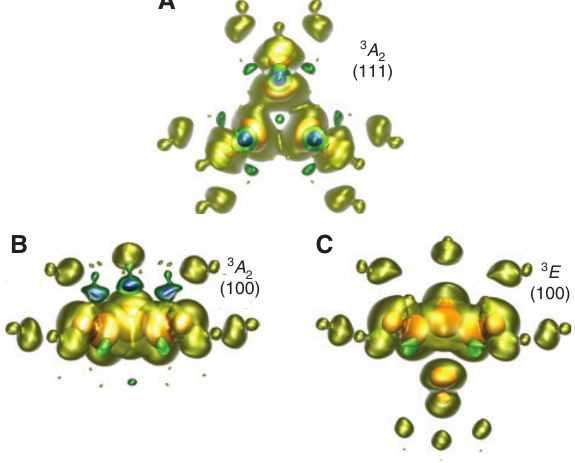
Figure 11: Calculated spin density in a 512-atom supercell in Ref. [3]. The isosurfaces of blue, green, yellow, orange, and red lobes are −0.014, −0.007, + 0.014, + 0.126, and + 0.478, respectively. (A) 3 A 2 state top view of the (111) plane. The threefold rotation symmetry of the C point group can be well identified with symmetrically 3 v equivalent ions around the vacancy. The red lobes show the position of the three carbon atoms near the vacancy with the largest localization of the spin density. (B) 3 A state side view of the (110) 2 plane. The spin density shows an oscillation in the plane of the three nearest carbon atoms around the vacancy. (C) 3 E side view of the (110) plane. The spin density is significantly localized on the nitrogen atom below the nearest three carbon atoms around the